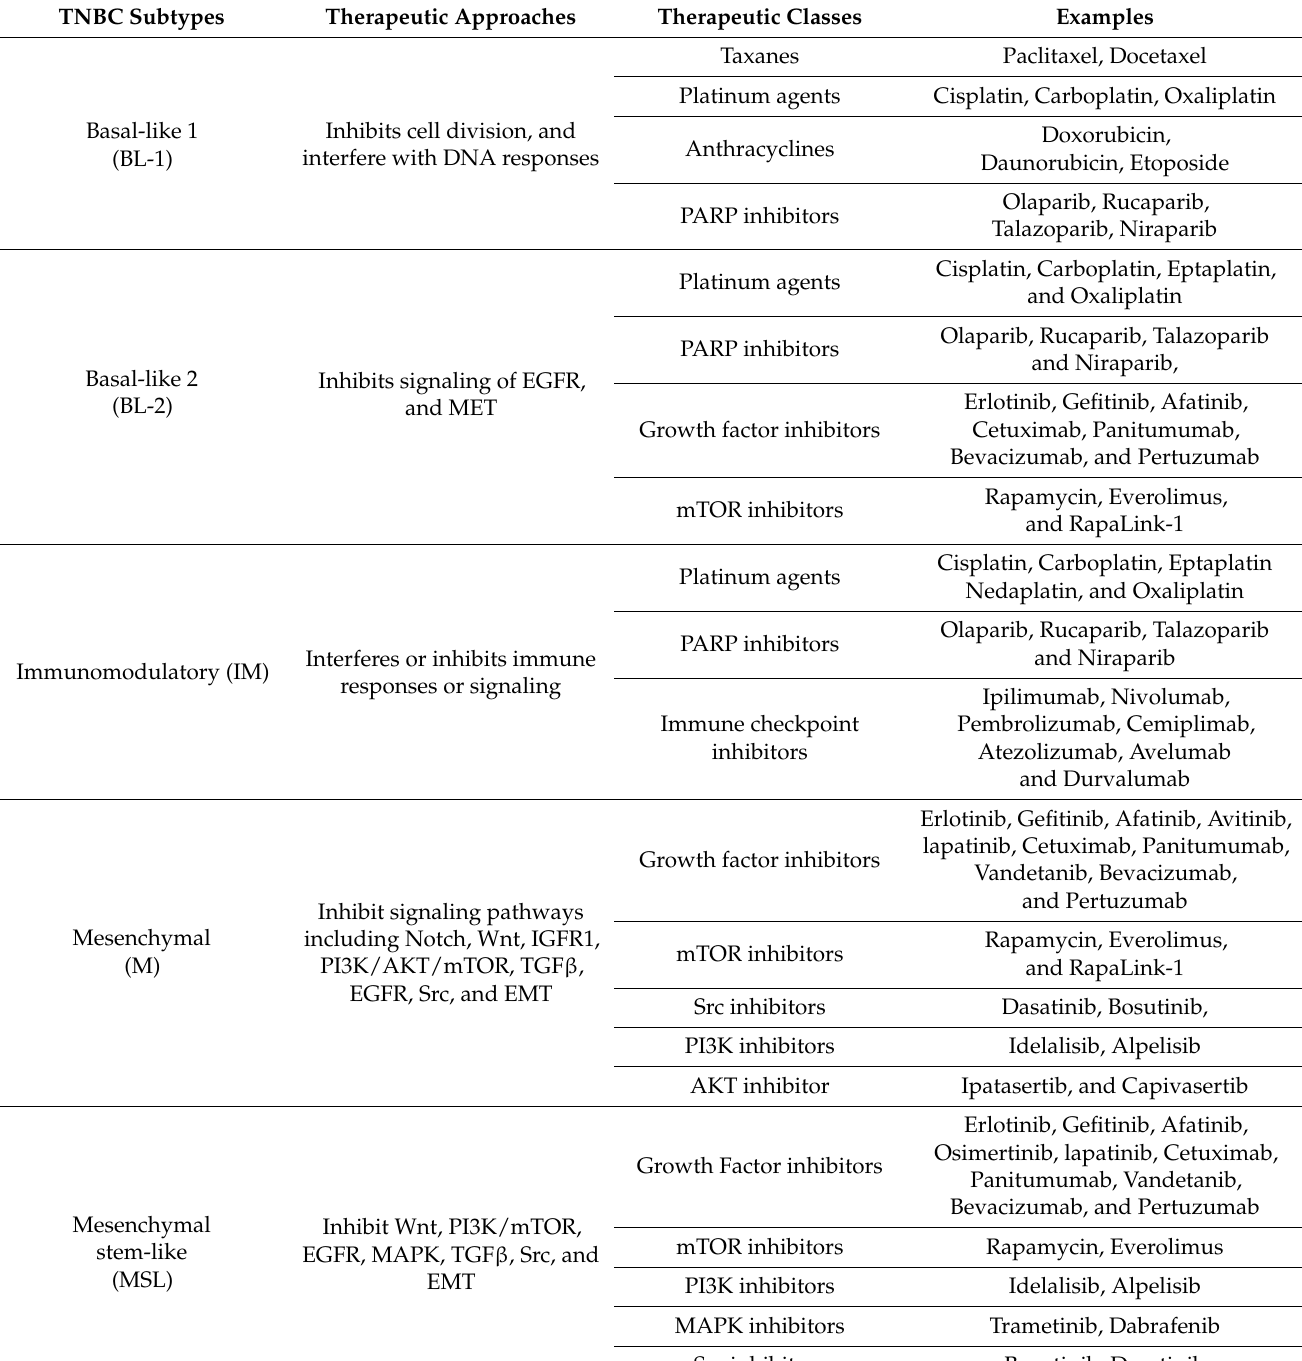
Table 1. Different classes of anticancer drugs and their suitability in different TNBC